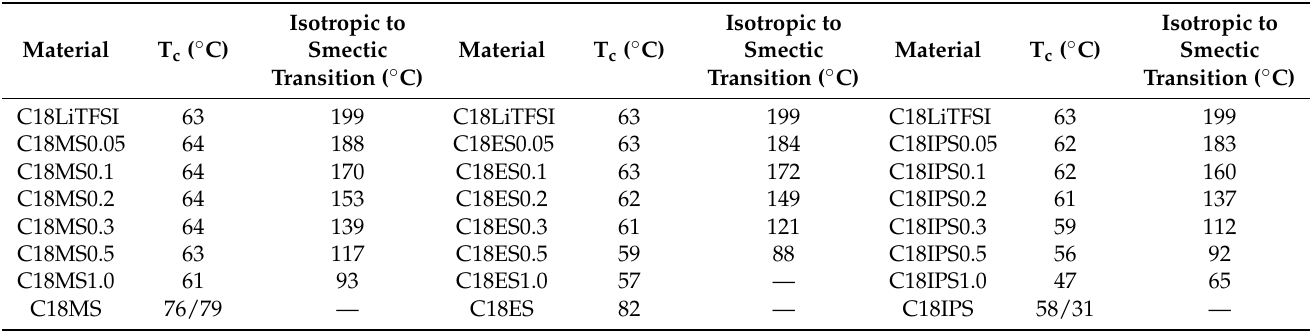
Table 1. Temperature values of the crystallization points (T c ) and isotropic to smectic transitions for all pure compounds and mixtures. These values were obtained from the DSC cooling scans. “—” indicates transitions not observed using DSC. Data for C18LiTFSI were originally reported in [21].